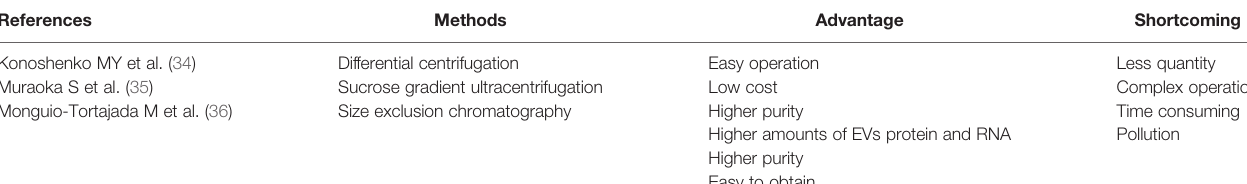
TABLE 1 | Advantage or disadvantages of isolation methods of extracellular